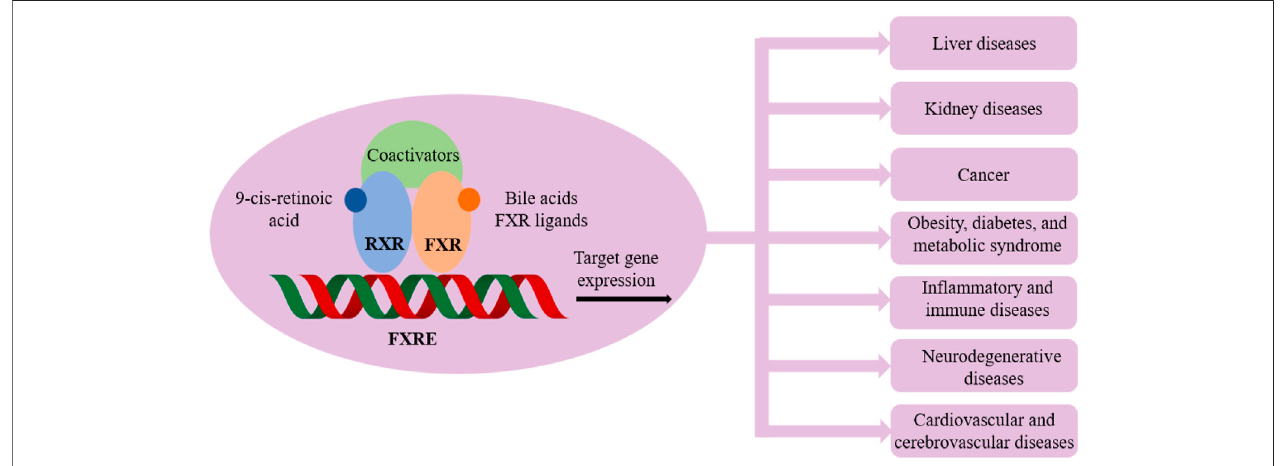
FIGURE 3 | Farnesoid X receptor (FXR) and related pathological conditions.